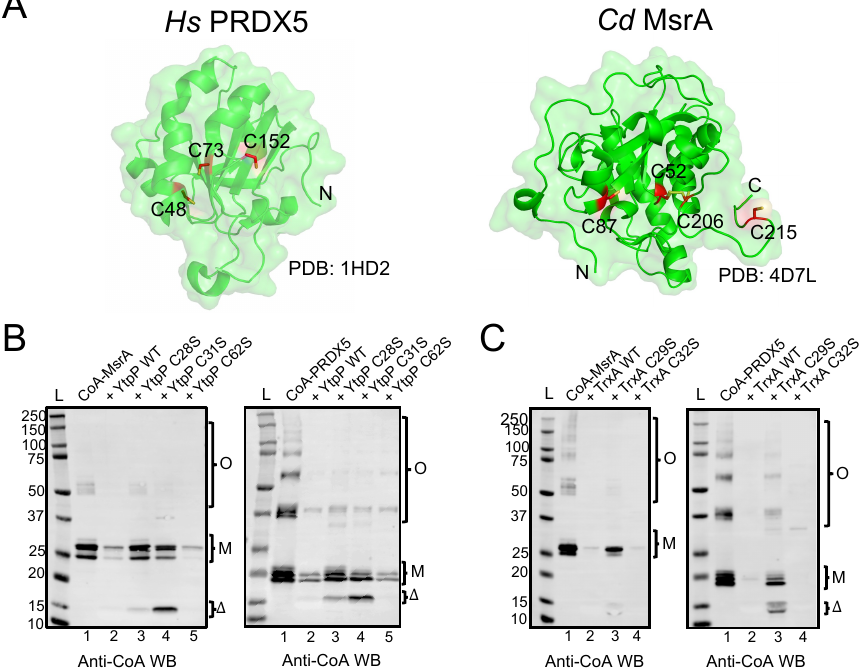
Figure 5. B. subtilis YtpP and TrxA deCoAlate CoA–MsrA and CoA–PRDX5. ( A ) Three-dimensional structures (green cartoon) of Hs PRDX5 (PDB: 1HD2) and Cd MsrA (PDB: 4D7L) are shown. The cysteine residues are shown in red sticks either buried within the structure or solvent-exposed. Anti- CoA WBs show that both B. subtilis ( B ) YtpP and ( C ) TrxA are capable of deCoAlating CoA–MsrA and CoA–PRDX5. “L” represents the protein ladder (kDa); Lane 1 represents the CoAlated protein (MsrA or PRDX5); Lane 2 represents the CoAlated protein in the presence of either YtpP or TrxA; Lane 3 represents the CoAlated protein in the presence of YtpP C28S or Trx C29S; Lane 4 represents the CoAlated protein in the presence of YtpP C31S or TrxA C32S; Lane 5 represents the CoAlated protein with YtpP C62S. The WBs shown are from 3 independent replicate experiments, and an equal amount of sample was loaded into each well. “M” represents the monomeric form of CoA–MsrA and CoA–PRDX5; “O” represents the oligomeric forms of CoA–MsrA and CoA–PRDX5; “ ∆ ” represents either CoAlated YtpP C28S or YtpP C31S, or CoAlated TrxA C29S. On the other hand, mutation of YtpP Cys 28 (C28S mutant) shows minor deCoAlation of CoA–MsrA monomeric and oligomeric bands (Figure 5B Left—Lane 3). Incubation of YtpP C28S mutant with CoA–PRDX5 shows complete deCoAlation of the oligomeric bands and minor deCoAlation of the monomeric bands (Figure 5B Right—Lane 3). This Cys 31 may initiate the deCoAlation of proteins. Overall, these results show that both Cys 28 and Cys 31 are required for the efficient deCoAlation of MsrA (Figure 5B Left—Lanes 1–4), while the presence of only Cys 28 was observed to efficiently deCoAlate PRDX5 (using